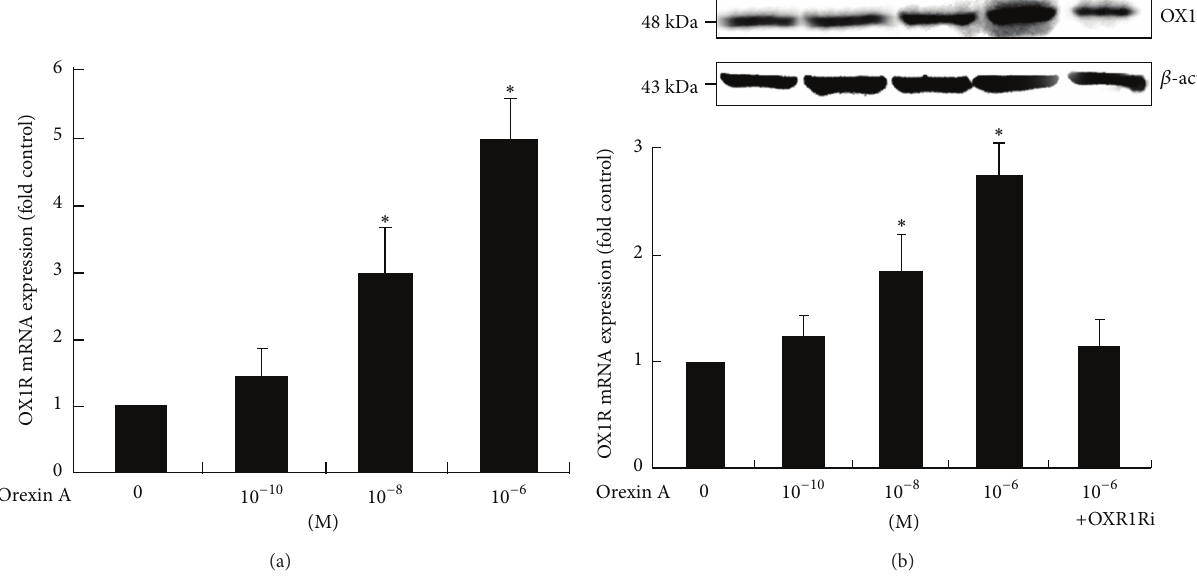
Figure 1: Effects of OXA on OX1R mRNA and protein expression in INS-1 cells. Cells were exposed to OXA at concentrations of 0M, 10 −8 M, 10 −10 M, and 10 −6 M for 24h. Another treatment group consisted of 10 −6 M OXA in the presence of the OX1R antagonist SB334867 (OX1Ri) (10 −6 M). The expressions of OX1R mRNA (a) and protein (b) were measured via real-time PCR and western blot analysis. Data are presented as mean ± SEM based on triplicate determinations from a representative experiment. Asterisks indicate significant differences compared to control ( ∗ 𝑃 < 0.05) .